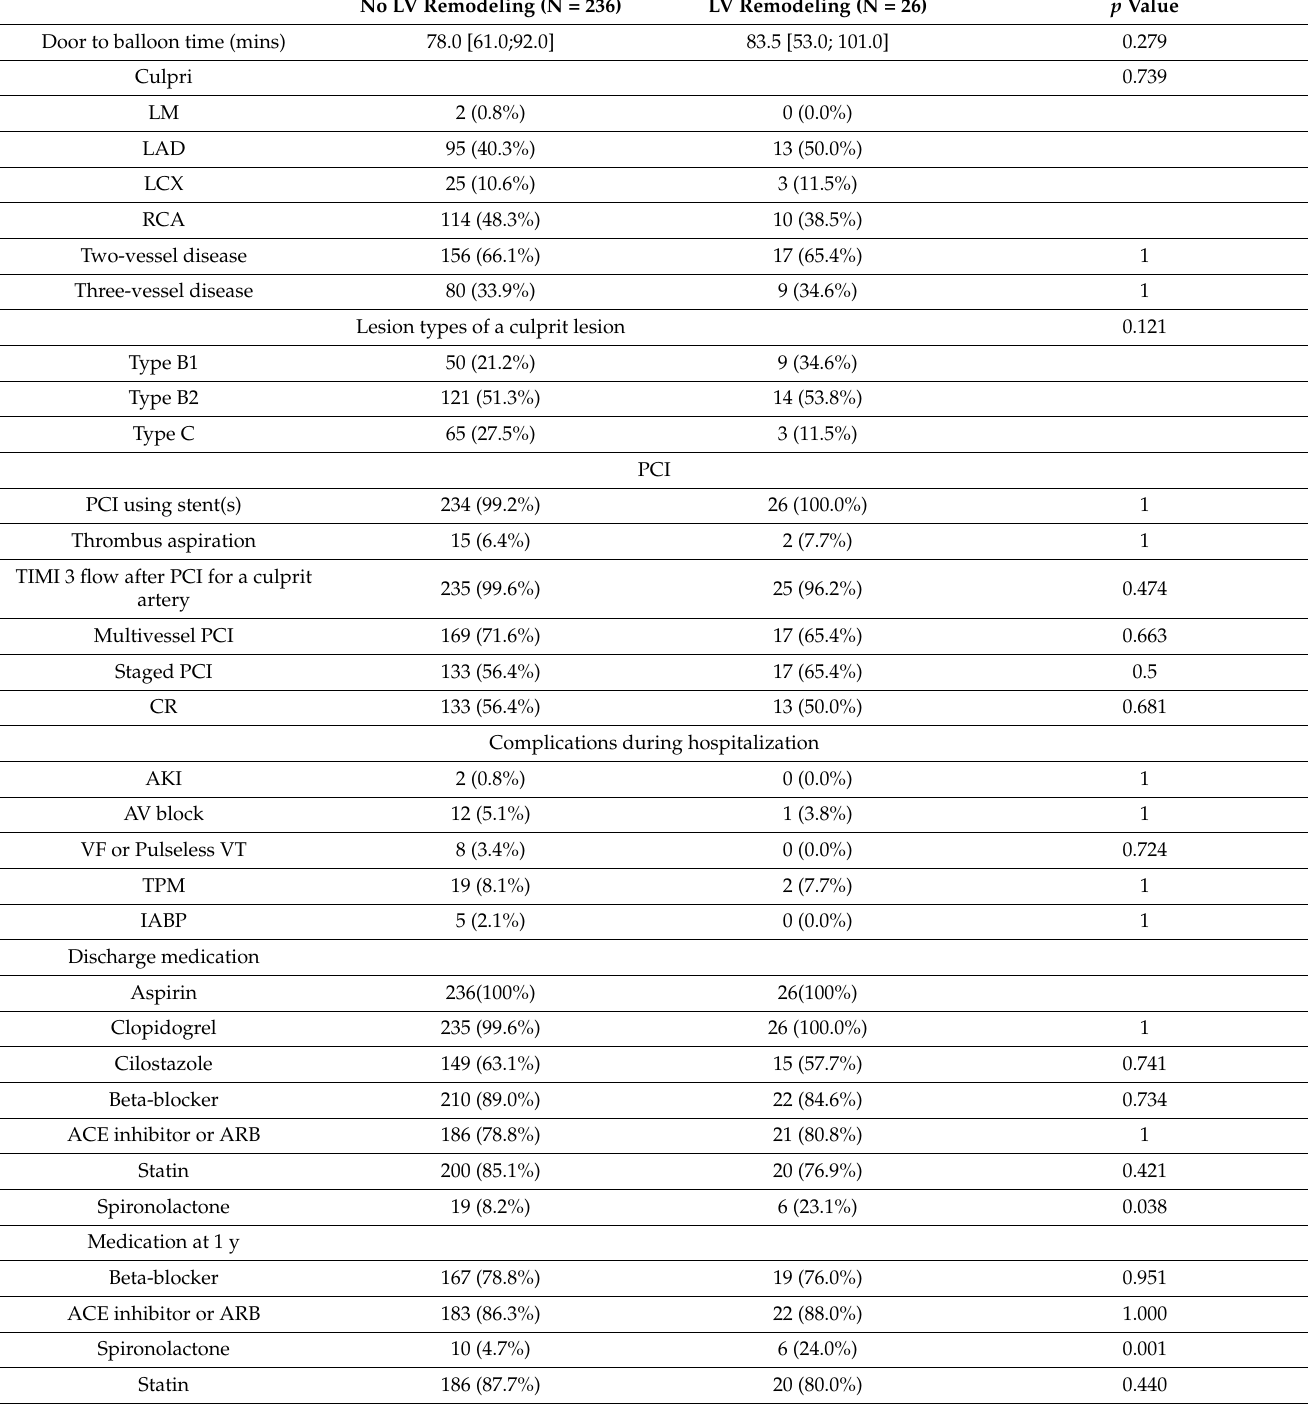
Table 2. Angiographic and therapeutic